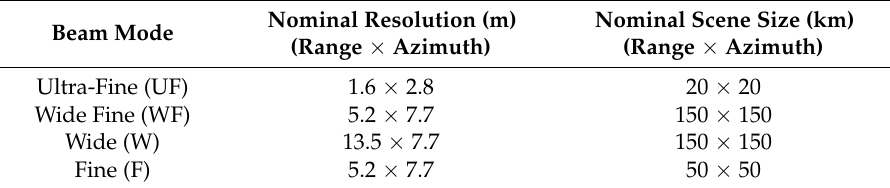
Table 1. Radarsat-2 Beam modes used in this study with nominal resolution and scene size.